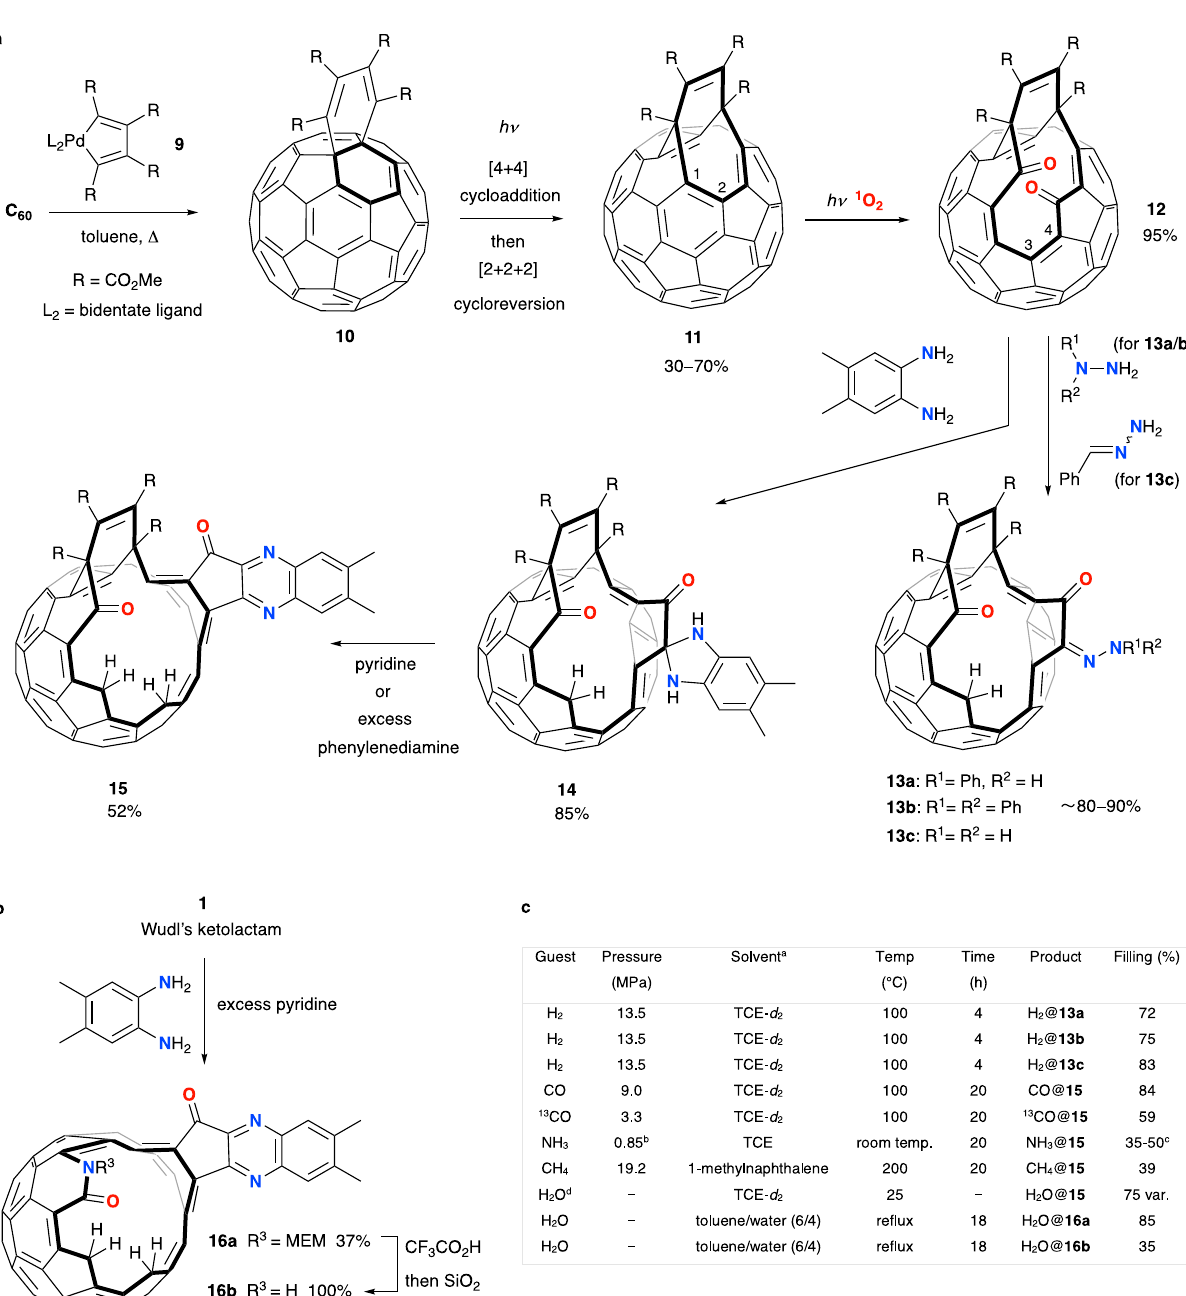
Fig. 2 Iwamatsu open-cage derivatives of C 60 and their encapsulation of molecular species. a An open-fullerene ( 11 ) with the core ethene-bridged structure of 8 is obtained in one-pot from C 60 , and undergoes regioselective oxidative cleavage. Widening of the opening is achieved by further reaction with a hydrazine or 1,2-diamine. b Wudl ’ s ketolactam 1 is also a substrate for ori fi ce-widening with an o -phenylenediamine. c Conditions for molecular guest encapsulation by open-fullerenes 13 , 15 and 16 ; a TCE = 1,1,2,2-tetrachloroethane, b Approx. 0.85MPa (i.e., vapour pressure of NH 3 at room temp.), − 10 °C, d H fi lling shows a c Partial loss of NH 3 occurs slowly, during 6 months storage at 2 O encapsulation by 15 occurs under ambient pressure and the % temperature-dependent entry/escape equilibrium (var. =